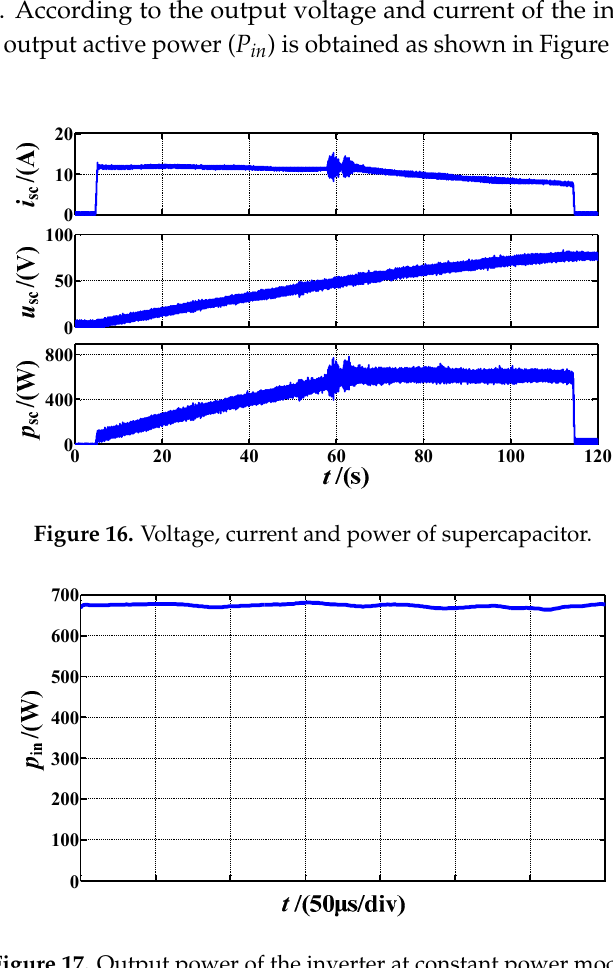
Figure 17. Output power of the inverter at constant power mode.